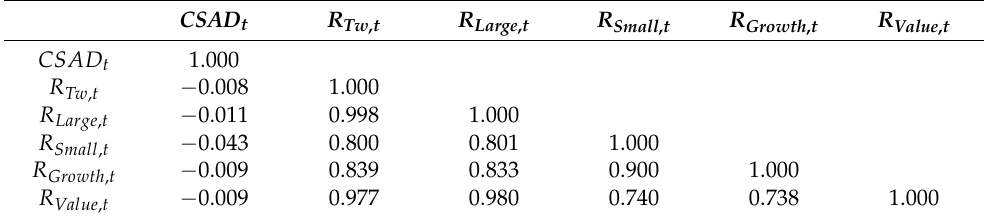
Table 2. The Pearson correlation coefficients. CSAD